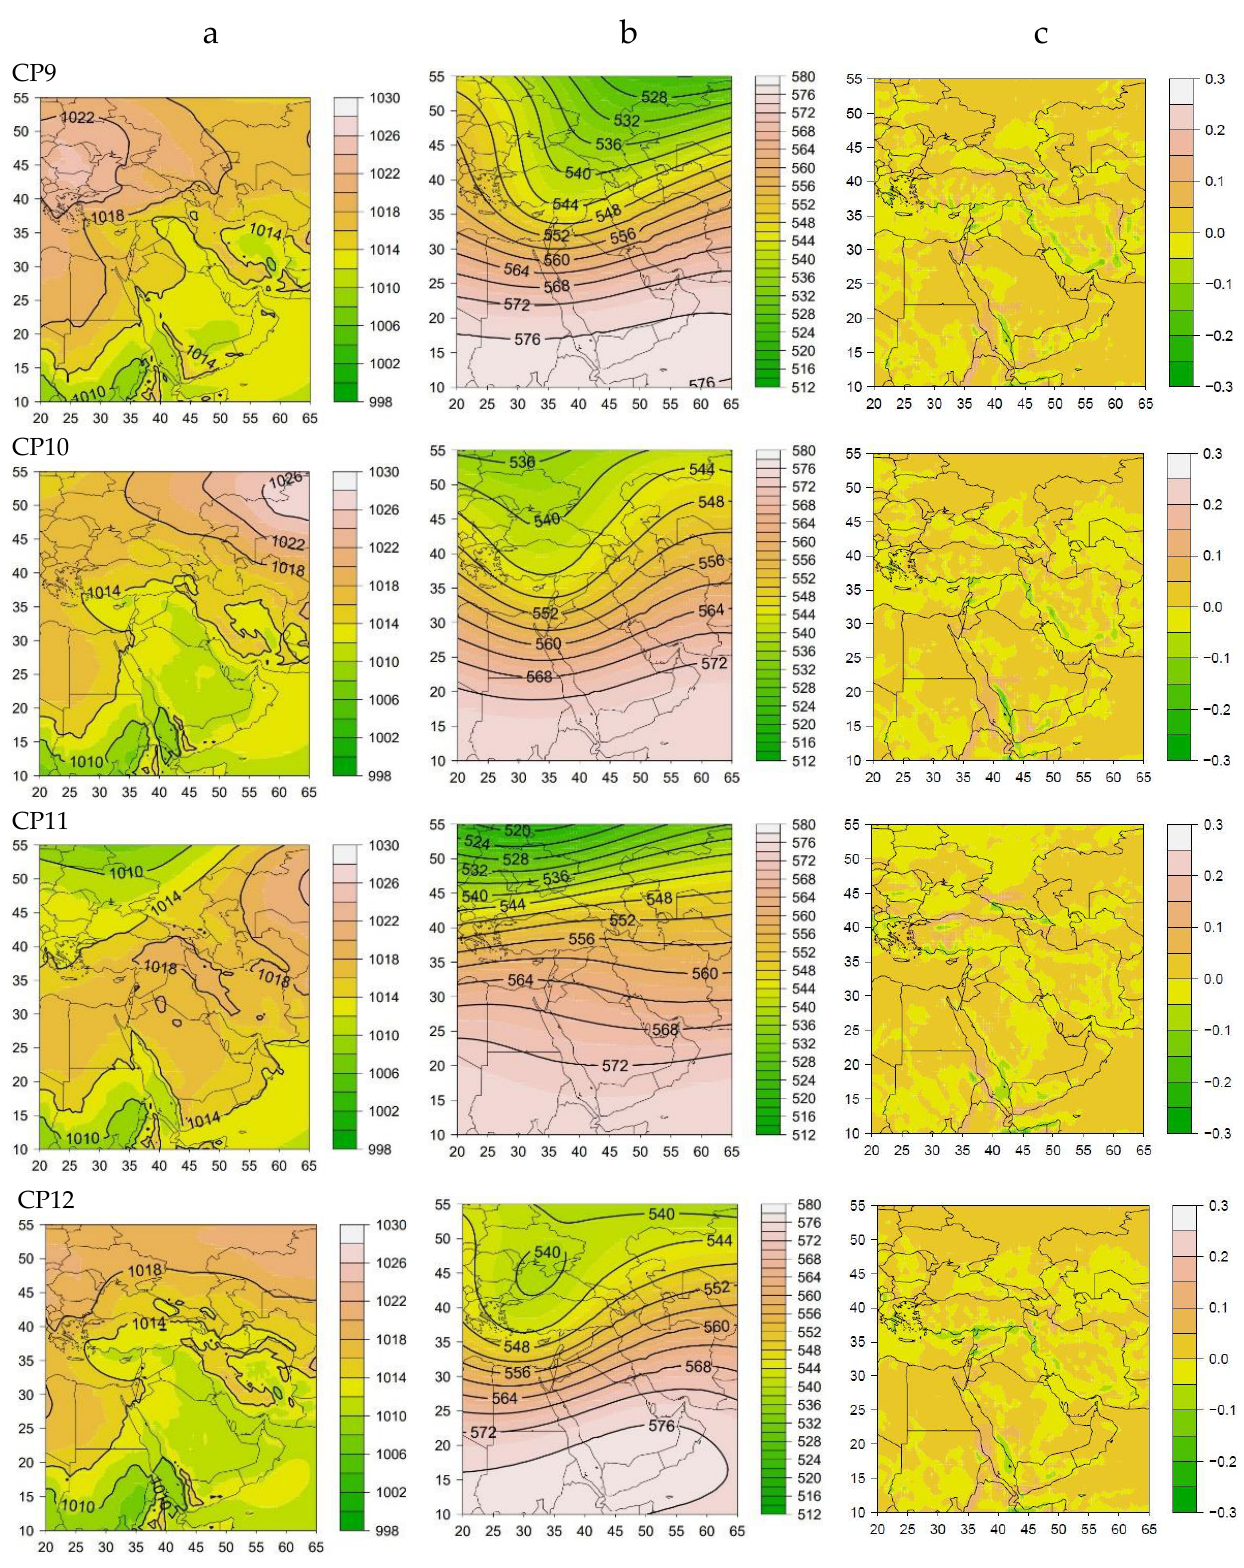
Figure 4. As in Figure 2, for patterns 9 – 12. Circulation pattern 15: A high pressure affects the northern parts of Iran and the Zag- ros Mountains, and a low pressure is observed on the Red Sea. A sub-tropical high is lo- cated in the south of the Red Sea and south of Saudi Arabia. A weak trough passes through high latitudes north of the Black Sea. There is a weak convergence of moisture flux in southwestern Turkey and south of the Red Sea. Wet conditions are likely to occur in the western parts of the country. Circulation pattern 16: A Siberian high pressure with a center of 1030 hPa has pene- trated the northeast of the Caspian Sea to the northern half of Iran. The low pressure is on the Mediterranean, and another low pressure is on the Red Sea, which is accompanied by a deep trough in the mid-level of the atmosphere in this region. Convergence of moisture flux is observed in the Red Sea, northeast of the Mediterranean Sea, and parts of the west- ern country. Therefore, wet events are expected in the western and southwestern regions of the country. Circulation pattern 17: The relatively low pressure that forms in the south of the Red Sea affects most parts of the country. There is a deep trough in the country ’ s northwest in the middle level of the atmosphere, which, in the southern part, stretches over Iraq, Saudi Arabia, and the Red Sea. Convergence of moisture flux is observed in most parts of the country, especially in the southern half of Iran. Favorable conditions for wet events are predicted in most parts of the country, especially the southwest and south. Circulation pattern 18: An Eastern European high pressure extends to the north of Iran, but most parts of the country are affected by thermal low pressure that extends from the Red Sea to Saudi Arabia, Iraq, and Iran. The subtropical high is observed from north- eastern Africa to southern Iran in the middle level of the atmosphere. There are two weak troughs in the eastern Mediterranean and another is in the northeast of the Caspian Sea. Convergence of moisture flux is in the southern shores of the Caspian Sea and eastern parts of Iran. Due to the passage of the shallow trough over the Caspian Sea and the north- ern currents of Eastern Europe, high pressure and wet events will happen in the southern shores of the Caspian Sea.